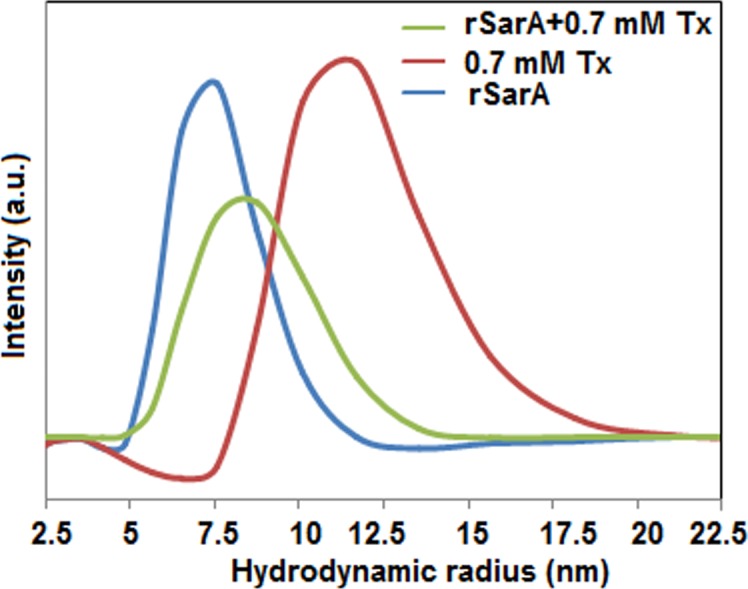
Shape of rSarA.Dynamic light scattering of rSarA, 0.7 mM TX-100, and rSarA plus 0.7 mM TX-100 (Tx). A set of scattering data are shown here.